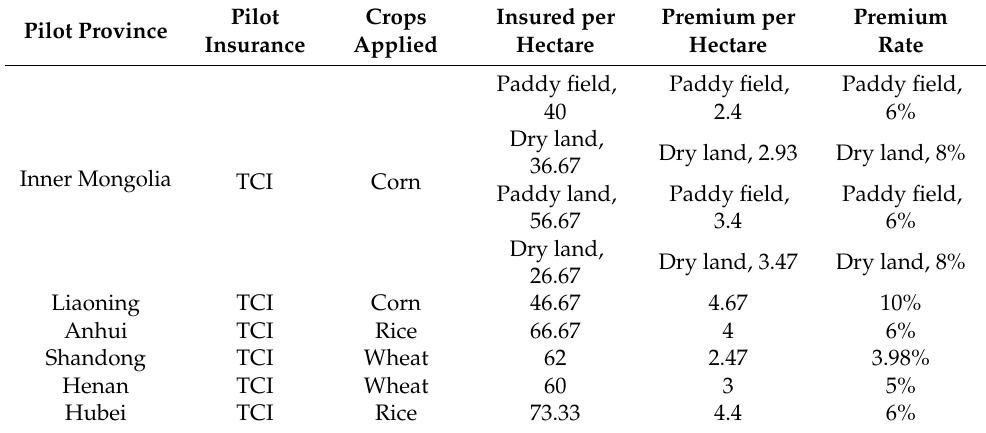
Table 1. Basic situation of